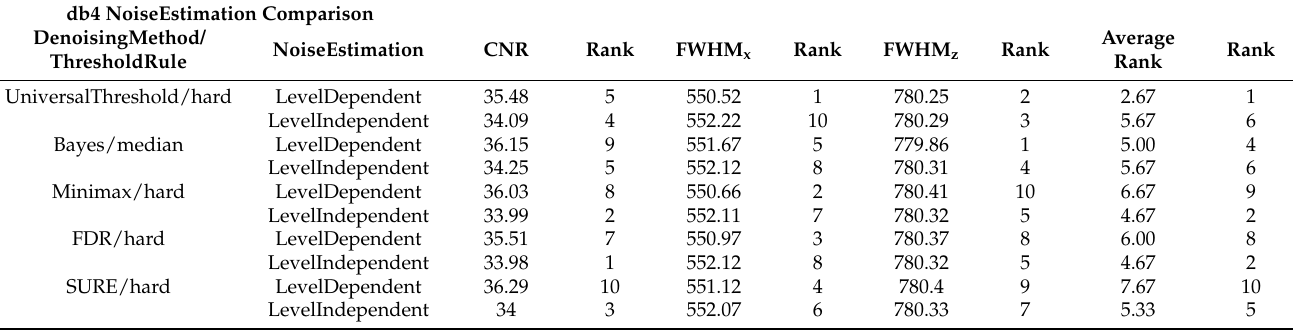
Table A3. Comparison of noise estimation with and without level